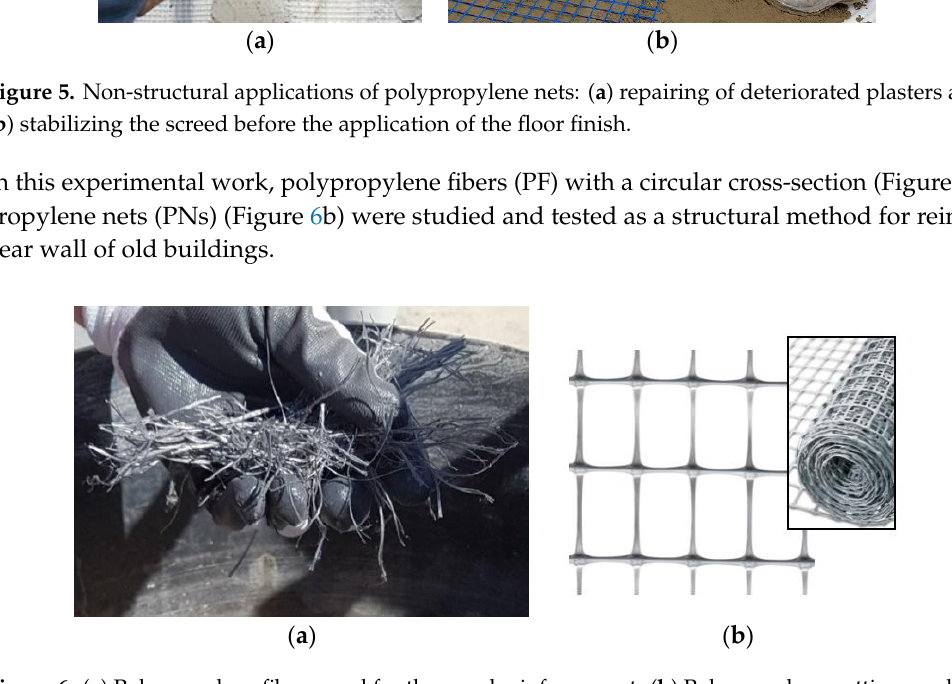
Table 1. Technical specifications of polypropylene fibers (100% polypropylene as a chemical base) used for the reinforcement of shear walls (from the producer’s datasheet).